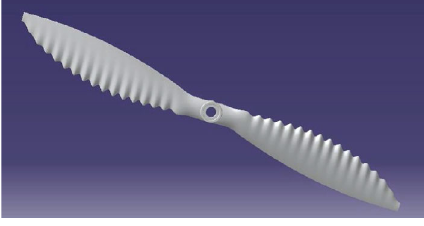
Figure 10: Design-3.